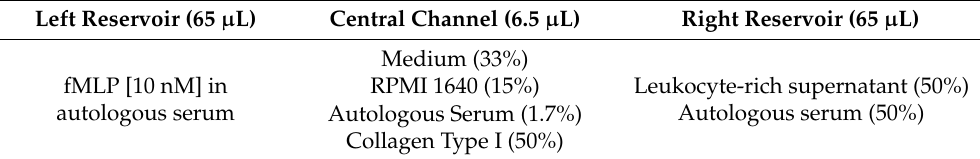
Table 1. Composition of the 3D- µ -Slide’s compartments. More detailed information about the components can be found in Table A1 in the Appendix